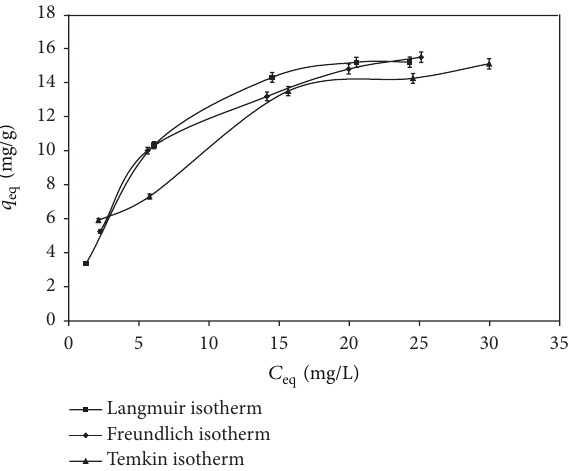
Figure 5: Effect of Ficus benghalensis L. dosage on biosorption of lead for 20mg/L of metal concentration and solution pH of 6.0. Figure 6: Langmuir, Freundlich, and Temkin isotherms plot for lead biosorption at 0.1g in 30 mL of biosorbent concentration and solution pH of 6.0.